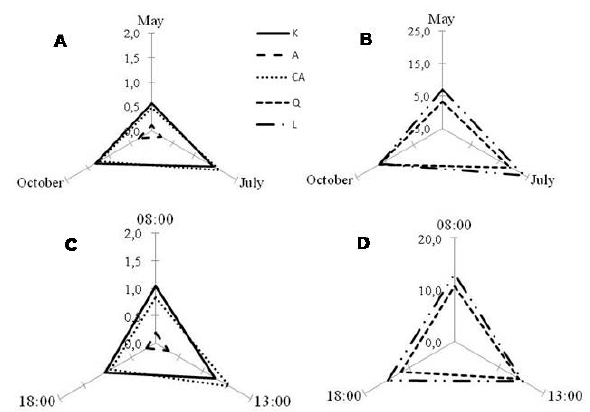
Figure 3. Monthly ( A and B ) and diurnal ( C and D ) variation of the different polyphenolic classes detected in Phillyrea latifolia leaf ethanolic extracts: A—apigenin derivatives; CA—caffeic acid derivatives; K—kaempferol derivatives; L—luteolin derivatives, and Q—quercetin derivatives. In general, for all compounds, monthly variation ( A and B ) was more prominent than diurnal ( C and D ), with May as the worst month for harvesting, regardless the time of the day. For caffeic acid derivatives (CA), irrespective of month, harvesting at 13:00 is better than other day times ( C ). Graphics were obtained with the mean values of the consecutive years of analysis (2014 and 2015, n=18). Compounds were represented in the same graphic according to their amounts. Molecules 2020 , 25 , x FOR PEER REVIEW In general, both TPC (Figure 4, upper graphics) and TFC (Figure 4, down graphics) were significantly affected by the month and time of the day ( p < 0.001). Particularly, TPC and TFC showed higher values in July (gray bars), followed by October (white bars) and May (black bars) (Figure 4). While considering the diurnal variations, TPC and TFC increased from 8:00 to 13:00 and decreased from 13:00 to 18:00. These diurnal behaviors agreed with the dynamics of the individual phenolic amounts (Table S1, Figure 3C and D), with higher values being obtained in leaves harvested in July at 13:00 (Table S1), except for apigenin derivatives, showing highest values at 13:00 in October (Table S1, Figure 3). Data of our study support the view that polyphenols, especially phenylpropanoids, in addition to absorbing the most energetic solar wavelengths and act as UV filters, may counter the oxidative stress [51–53] generated by long exposure to the harsh environmental conditions of the Mediterranean summer days, characterized by high temperatures, high light intensity and concomitant drought [6].